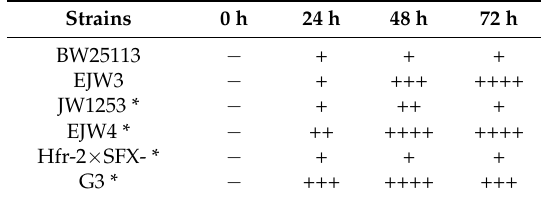
Table 2. Growth in micro-aerobic condition in M9 supplemented with 0.8 M NaCl.